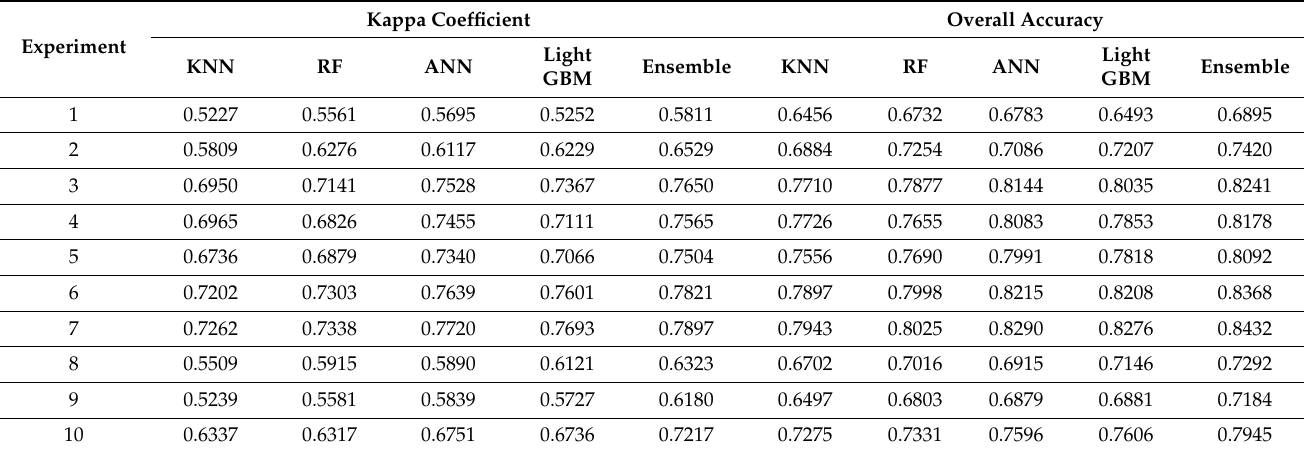
Table 7. Classification accuracy of different